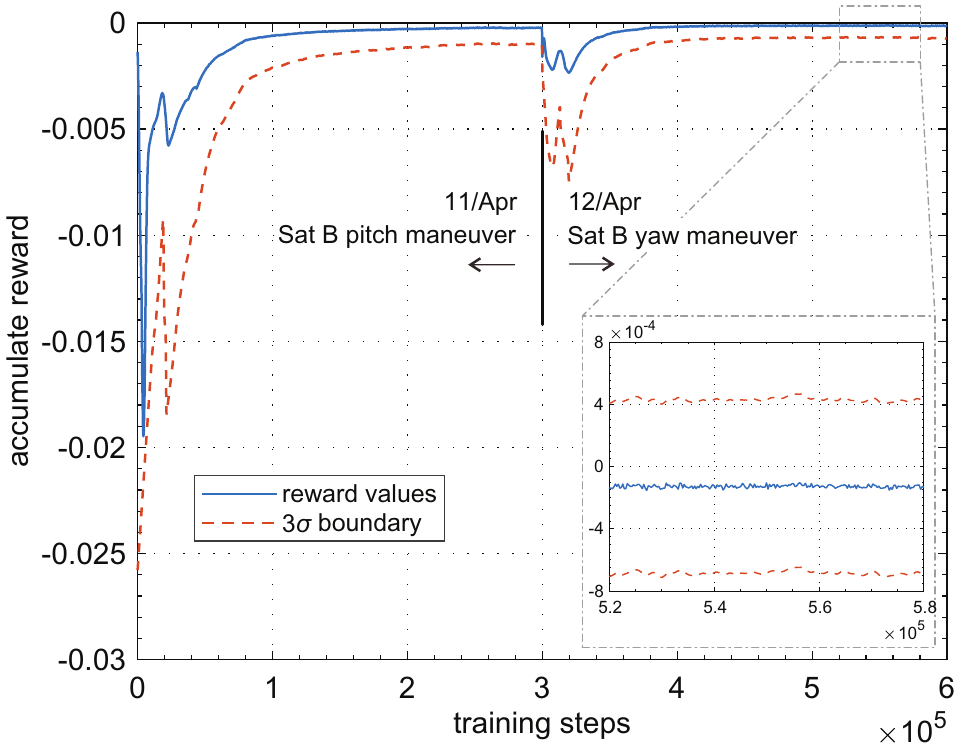
Figure 17. Learning data for on-orbit APC calibration during 11/12